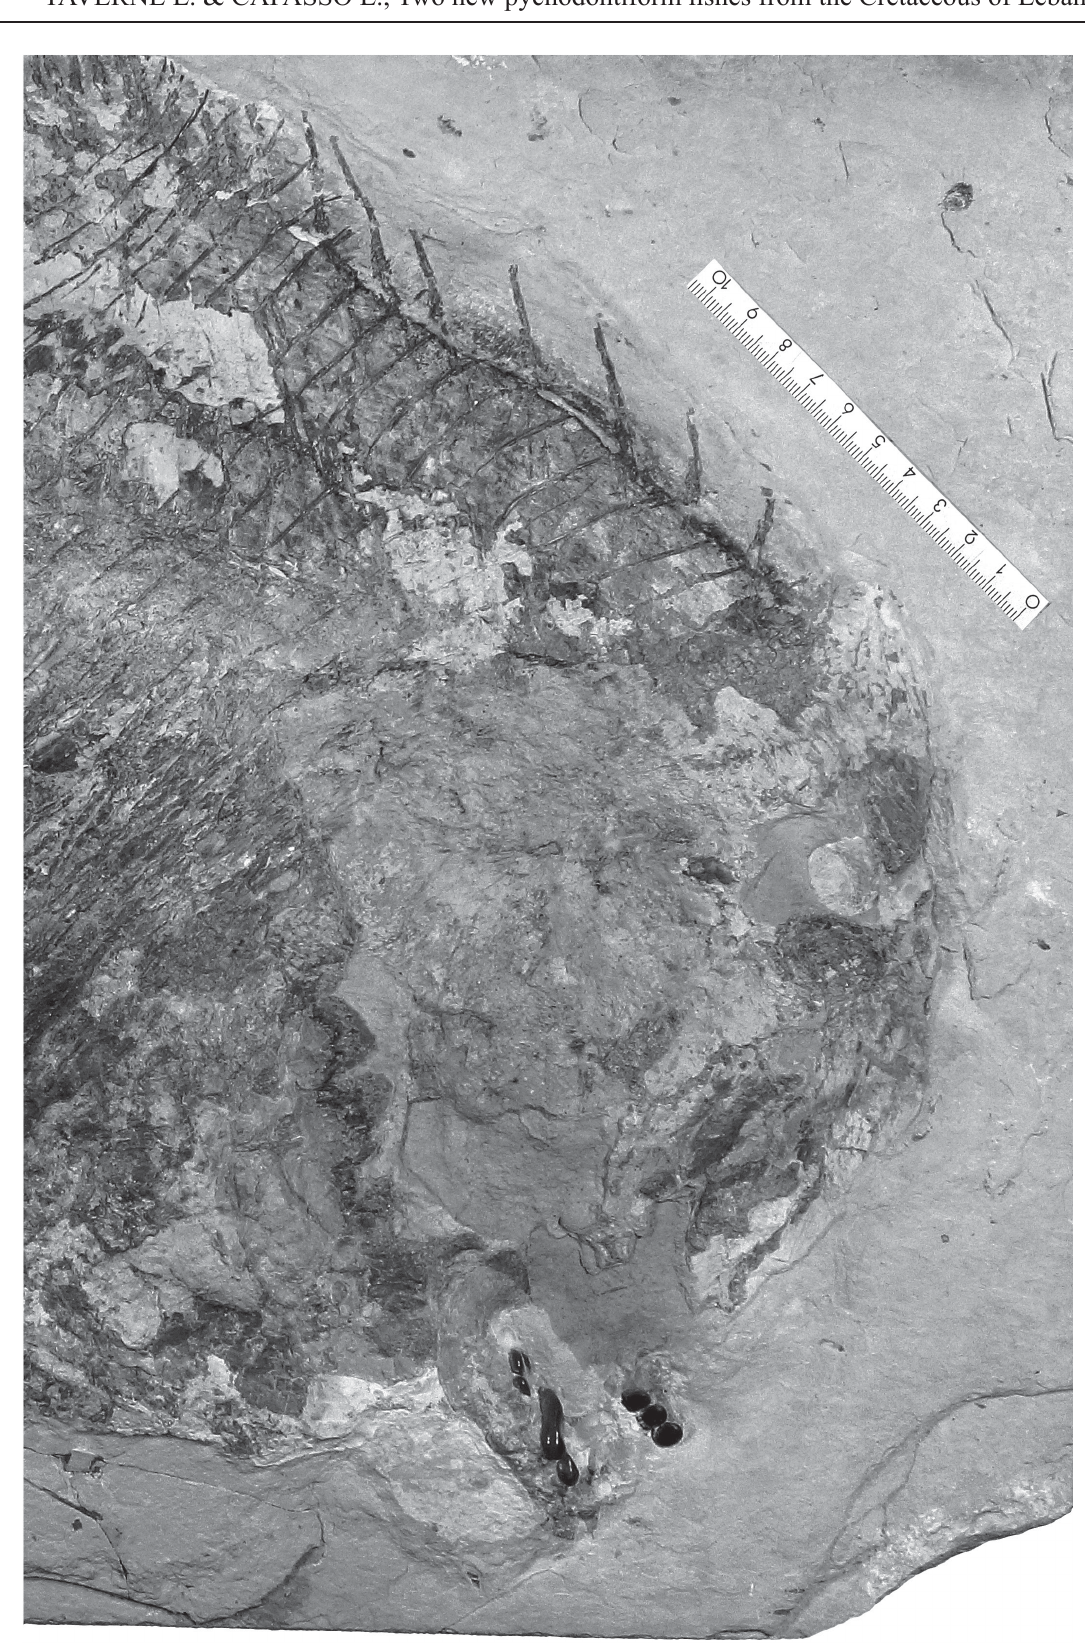
TAVERNE L. & CAPASSO L., Two new pycnodontiform fishes from the Cretaceous of